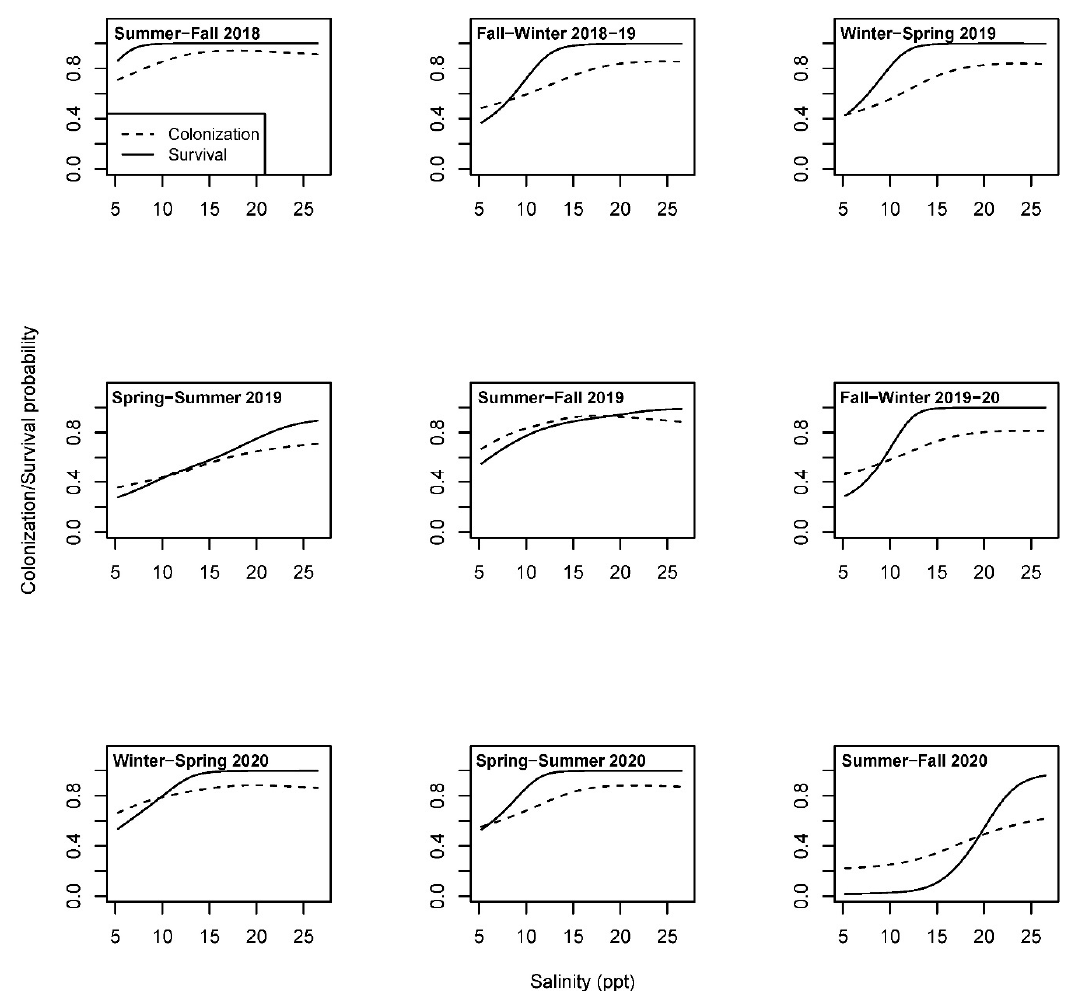
Figure 5. Mean back-transformed predictions of colonization (dashed lines) and survival probability (solid lines) ( y -axis) of juvenile blue crabs Callinectes sapidus in North Carolina (USA) tidal creeks as a function of mean site-level salinity (parts-per-thousand (ppt) ( x -axis). Colonization and survival were predicted for the interval between successive seasons from fitting a dynamic occupancy model to crab presence/absence data. Predictions were made across the range of mean site-level salinity values recorded in this study. The single legend (in the first panel) applies to all graph panels. The final fitted occupancy model included a single meaningful covariate in the ob- servation sub-model. Water temperature was a positive covariate of detection probability (Figure 6, Table 4). The masses of the posteriors for the other two effects considered in the observation sub-model (mean site-level salinity and dissolved oxygen) widely overlapped zero. At the mean occasion-specific water temperature, the back-transformed estimate of detection probability across all seasons and sites was 0.186. The value for the convergence statistic ( 𝑅(cid:3552) ) was less than 1.1 for each modeled parameter in both the preliminary and final models; these statistics and trace plots indicated the adequate mixing of chains of retained updates of each modeled parameter.